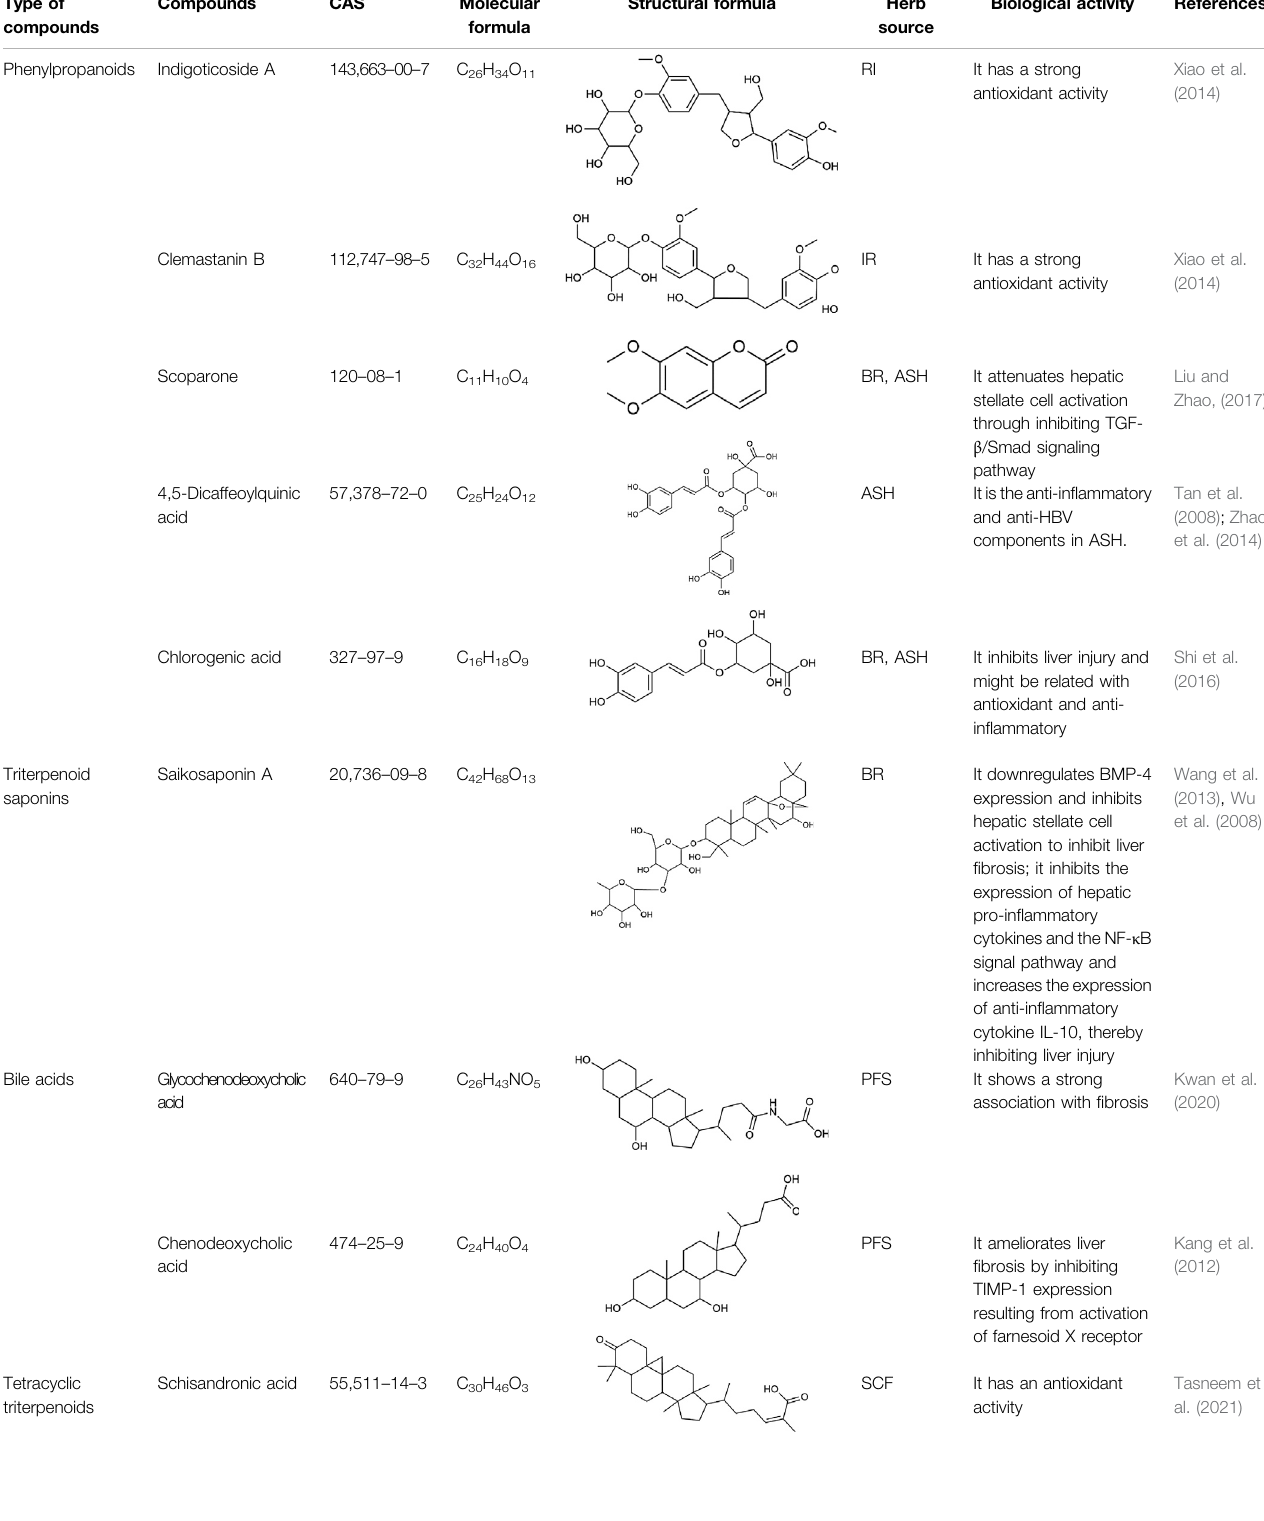
TABLE 2 | ( Continued ) Screening results of active ingredients of Hugan